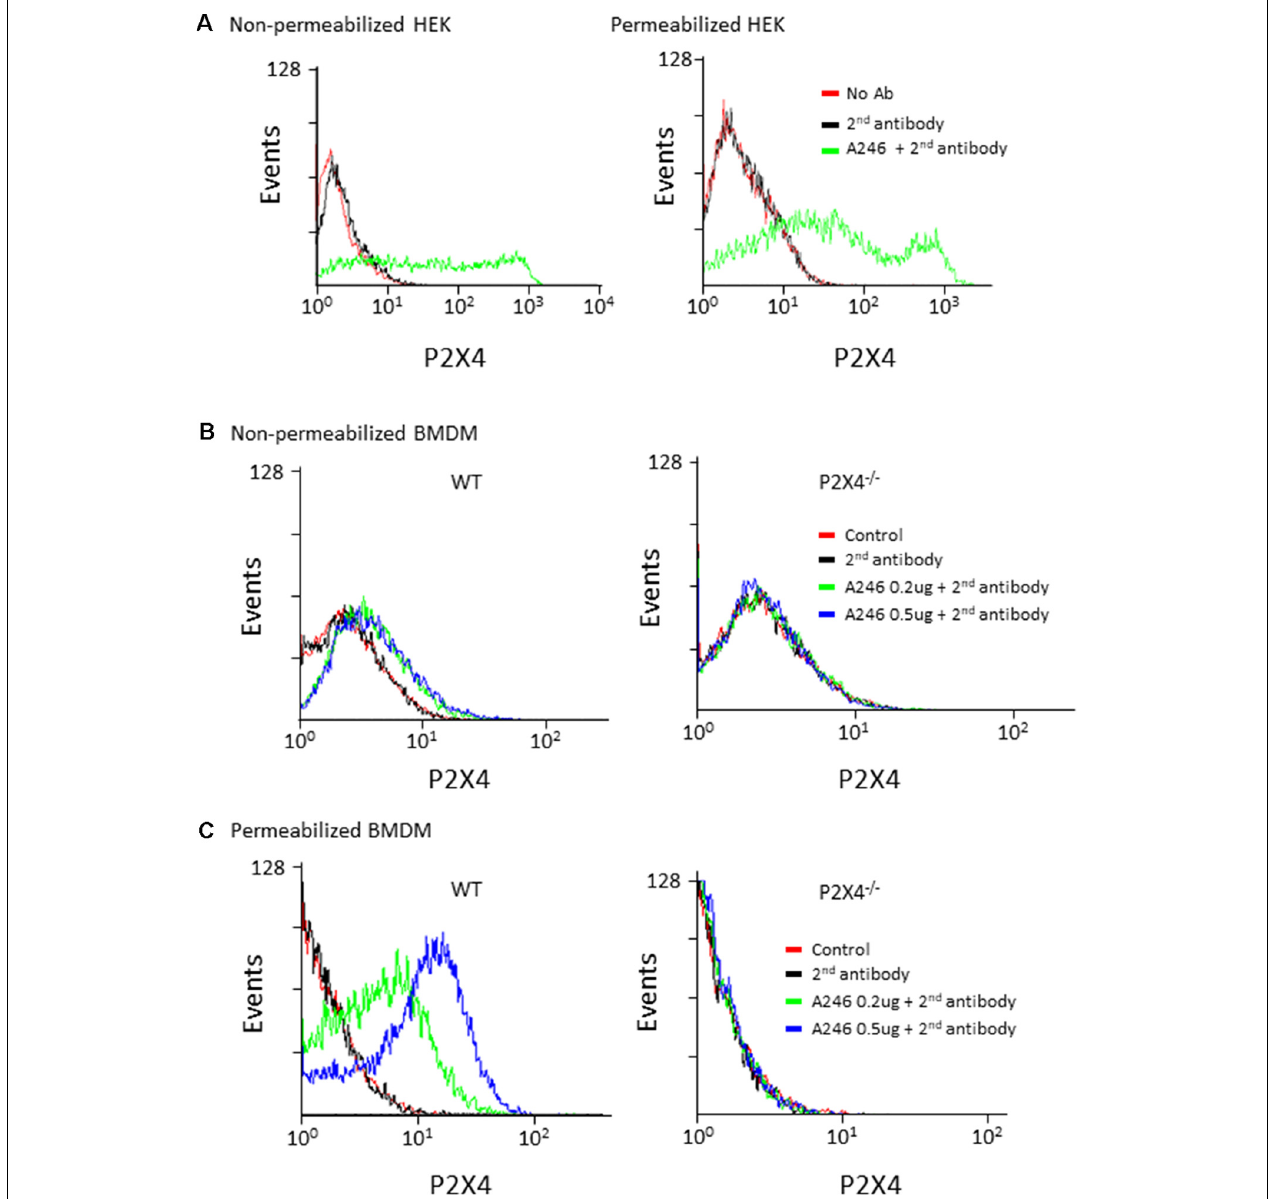
FIGURE 3 | Flow cytometry analysis of mouse P2X4 expression using Nodu 246. (A) Cell surface and intracellular expression of mouse P2X4 by P2X4-transfected and non-transfected HEK cells was assessed by flow cytometry after sequential incubation of cells with rat mAb Nodu 246 followed by a secondary PE-conjugated anti-rat-IgG antibody (2nd antibody), in non-permeabilized or permeabilized cells. Similar experiments were performed with BMDM obtained from WT and P2X4 − / − mice. Cells were either non-permeabilized (B) or permeabilized (C) . Note that permeabilization greatly enhanced the detection of mouse P2X4 in BMDM, further supporting the intracellular localization of the native